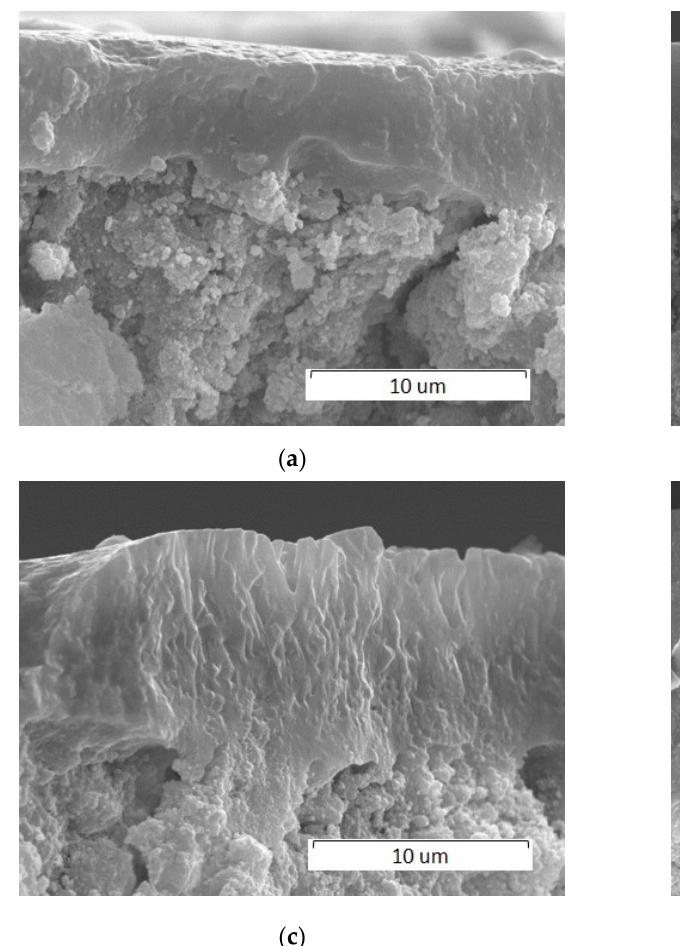
Figure 9. SEM images of pellet surface treated by a 0.2 mm laser spot at 4 W and at different scanning speeds, mm/s: ( a ) 700; ( b ) 500; ( c ) 300; and ( d ) 100. The inset shows a cross section of the specified area.